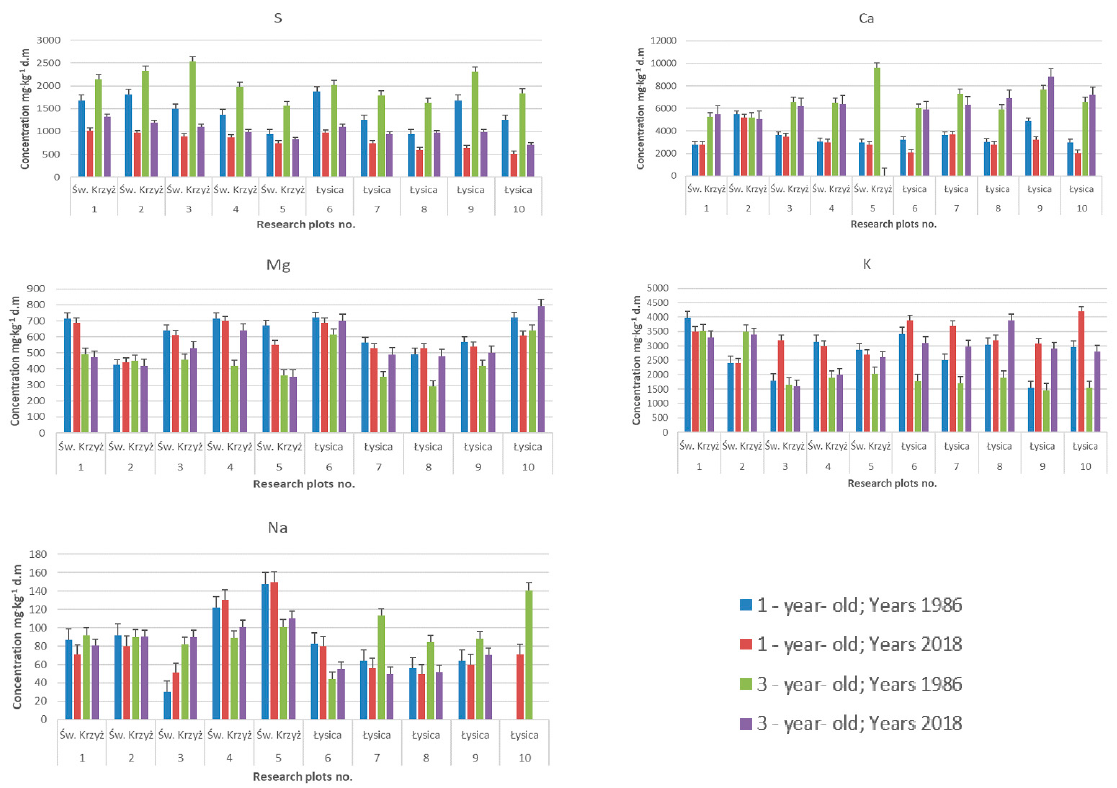
Figure 2. The contents of selected macronutrients in 1-year-old and 3-year-old silver fir needles in milligrams per kilogram of dry matter (mg·kg − 1 d.m (mean values ± standard deviation (SD)).